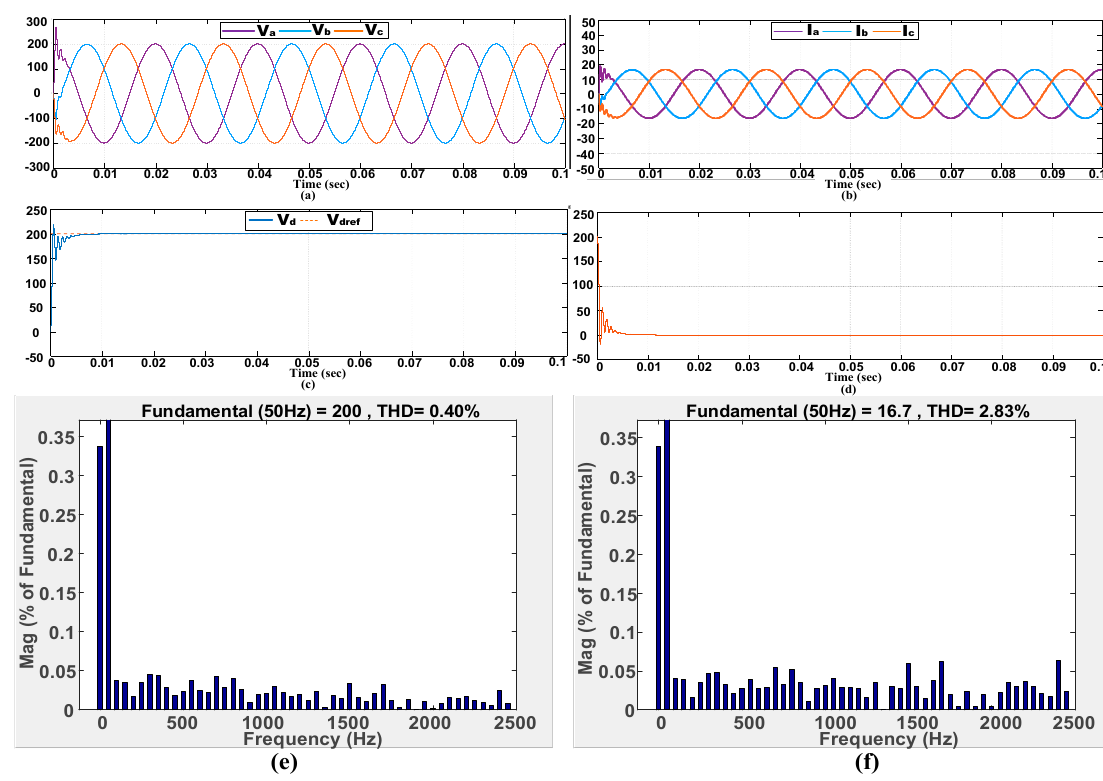
Figure 7. Simulation results with the DB predictive controller in steady-state condition. ( a ) Output voltage ( b ) Load current, ( c ) α -frame voltage waveform, ( d ) Voltage tracking error, ( e ) Voltage THD, ( f ) Current THD.